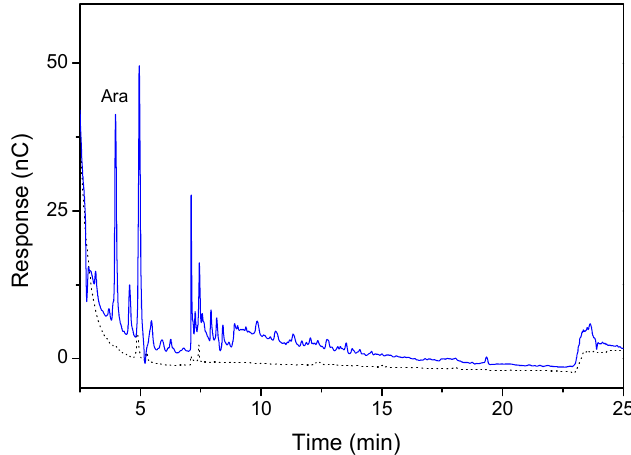
Figure 1. High-performance anion exchange chromatography (HPAEC) analysis of the hydrolysis of arabinoxylan by Paenibacillus polymyxa enzyme extract. Reaction mixture containing 0.1 mg/mL enzyme extract and 5 mg/mL arabinoxylan was incubated at 37 °C for 24 h. The reaction was terminated by boiling the sample for 5 min, and the product was detected by HPAEC using a CarboPac PA-200 analytical column (3 × 250 mm). The black dotted line represents the substrate (wheat arabinoxylan) and the blue line represents the transformed product.